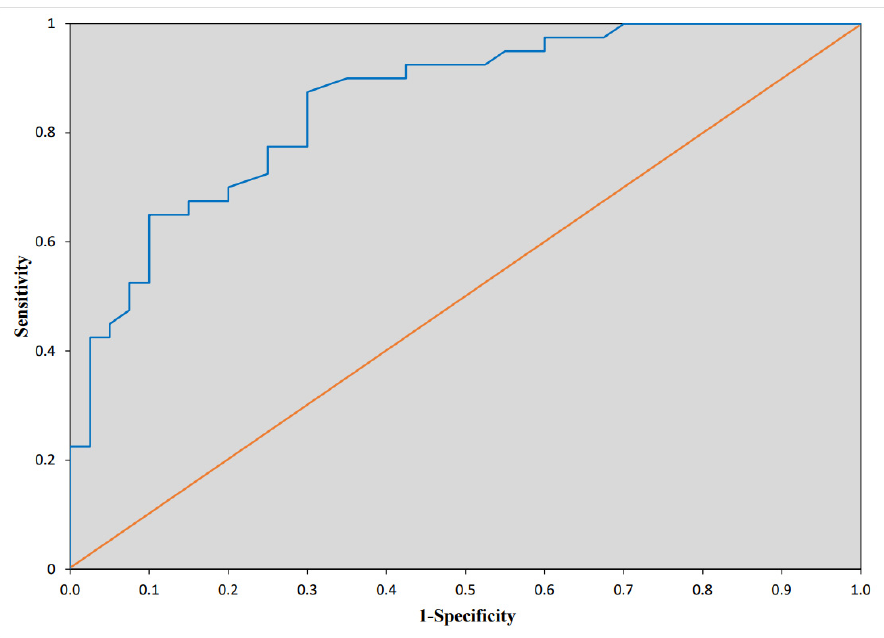
Figure 1. Receiving operator curve of left atrial (LA) strain to predict early atrial fibrillation (AF) recurrence after electrical cardioversion (ECV).